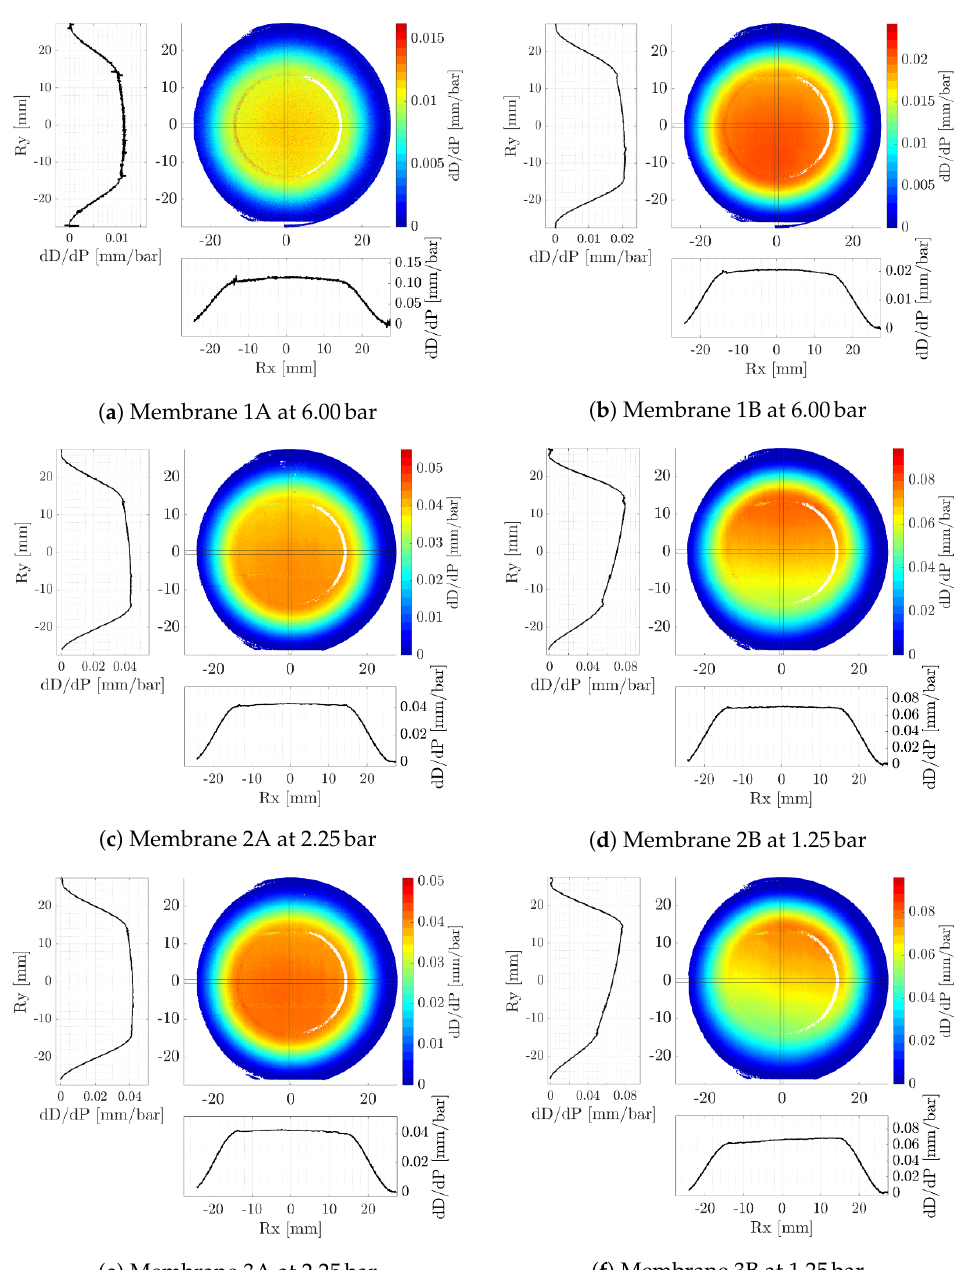
Figure 5. Colour maps of the specific displacements at a certain pressure of the membranes. Bellow and at the side of each colour map the average specific displacement of a 1mm wide section, as indicated with fine black lines, in the print direction ( y -axis, vertically) and perpendicular to the print direction ( x -axis, horizontally) is displayed. This section gives a clear view of the skewing of the thinnest prototypes (Figure 5d,f) in the direction of